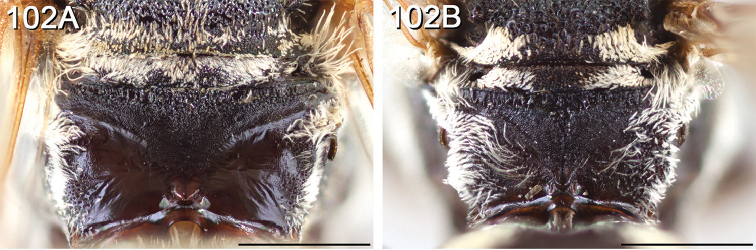
Propodeum (in posterior view) of female A
E.
splendidus paratype and B
E.
canadensis. Scale bars 1 mm.